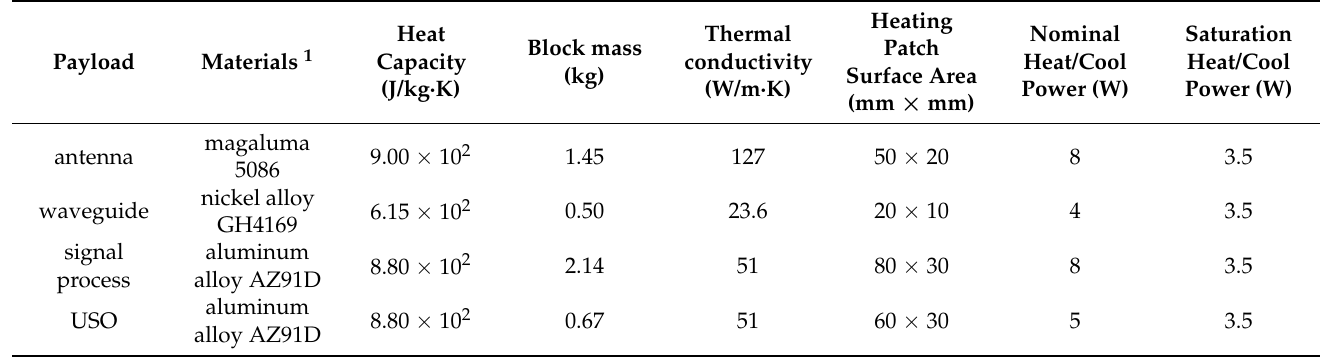
Table 1. Metal materials and heating/cooling parameters of MWR thermal test.